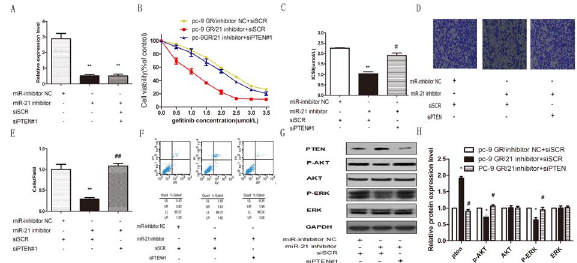
Figure 5. Effects of miR-21 knockdown and Pten down- regulation in Pc 9/GR cell lines. (A) Relative expression levels of miR-21 in pc-9 GR/inhibitor NC + scramble siRNA(siSCR) transfected cells, pc-9 GR/miR-21 inhibitor + scramble siRNA(siSCR) transfected cells and pc-9 GR/miR-21 inhibitor + Pten siRNA transfected cells were assessed by stem-loop qRT-PCR, and normalized to the levels of U6. Triplicate assays were performed for each RNA sample. Significant differences are indicated by **(P , 0.01). (B) Gefitinib sensitivity of pc-9